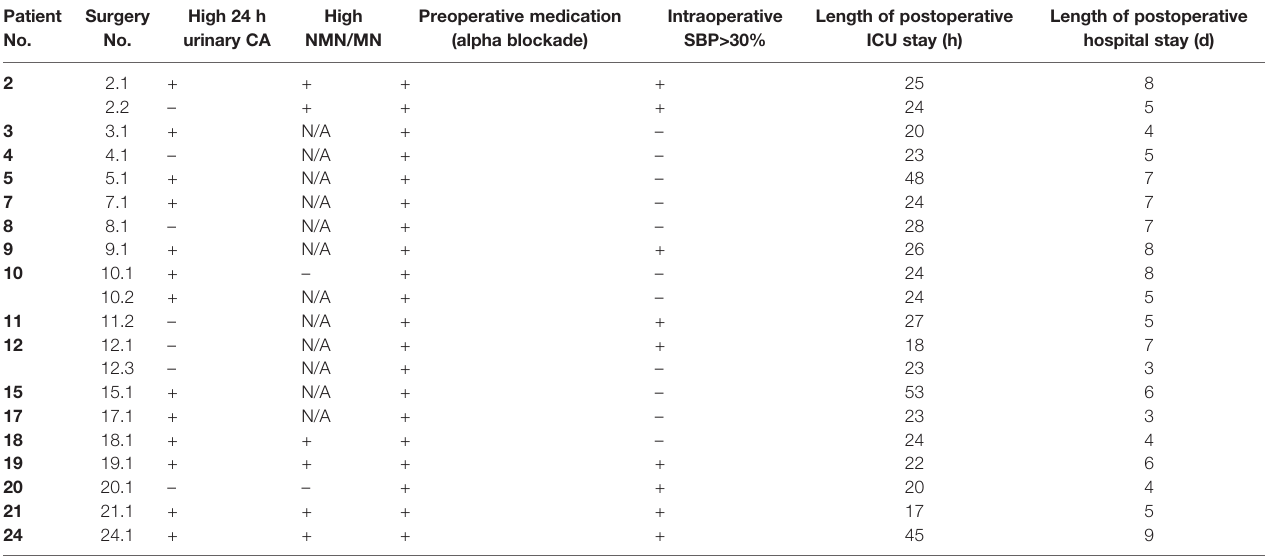
TABLE 2 | Clinical features and outcomes of 20 pheochromocytoma resection surgeries in 17 MEN2A cases. Patient